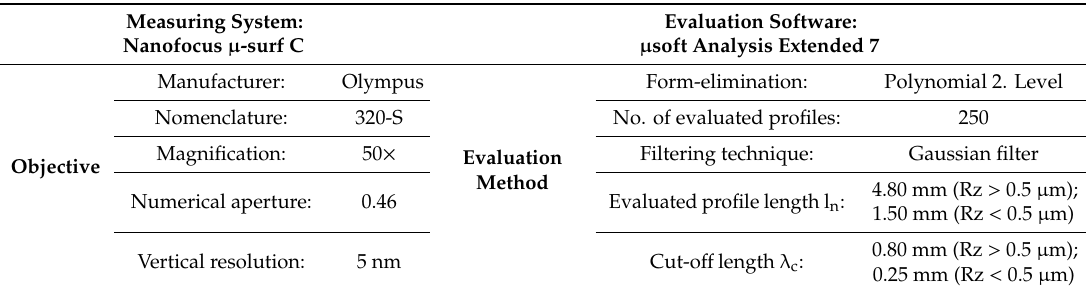
Table 1. Information on roughness measurements and evaluation.